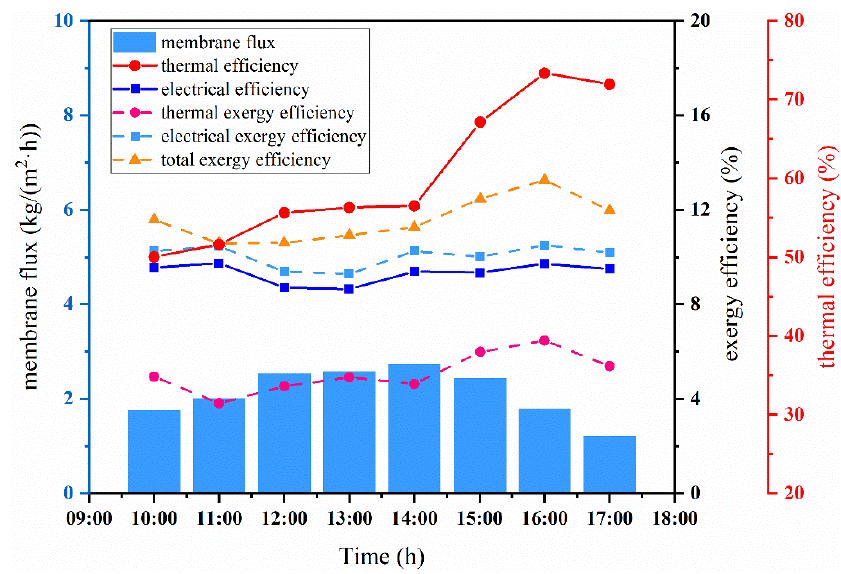
Figure 6. Electrothermal efficiency and exergy efficiency of LCPV/T-VMD system.